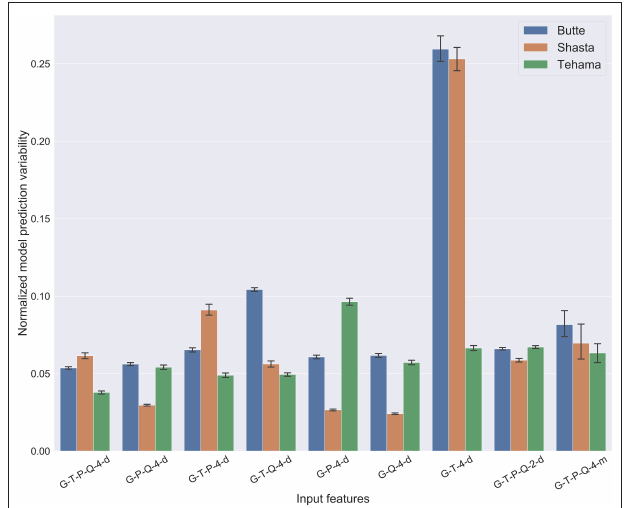
FIGURE 5 | Barplot comparing normalized model prediction variability ( S ). Lower S values indicate more robust MLP models that make more reliable predictions, while higher values indicate a higher variability in future predictions. The model prediction variability S is also normalized in the same way as the mean prediction error ( δ ). The standard deviation of S , represented by the black line on each bar indicates the variation in the ensemble prediction spread across all time steps.